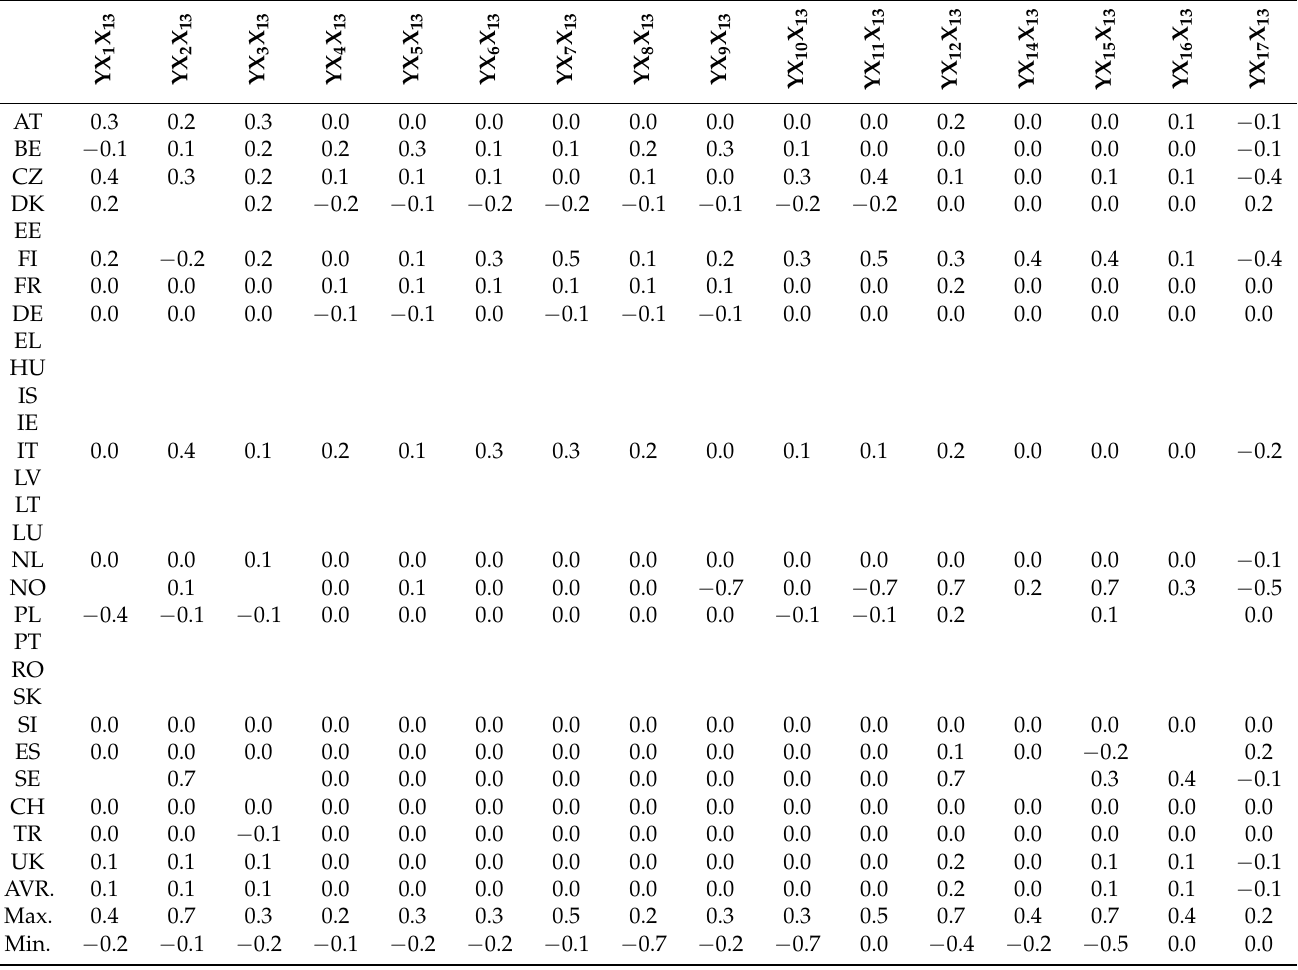
Table 8. Tri-dimensional synergy—YX i X 13